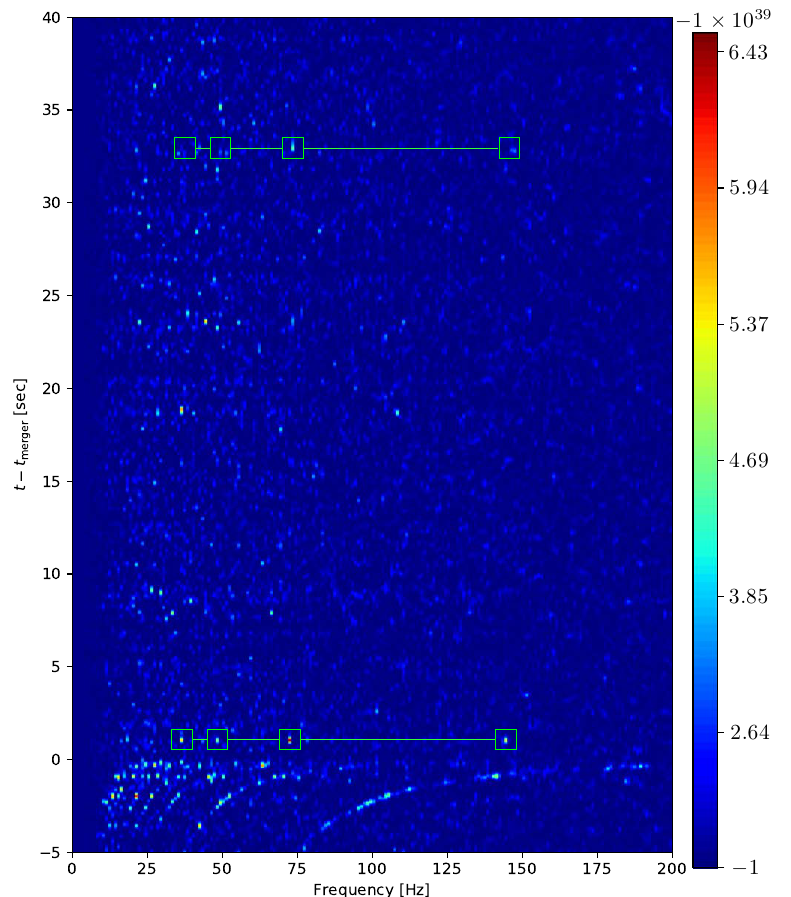
Figure 22. Time-frequency representations of X ( t , f ) (Equation (154); combining all harmonics with N ) around the merger for the BNS gravitational-wave event GW170817, frequencies n f , with n × ∈ observed through cross-correlating the two LIGO detectors [20]. The possible resonance peaks of echoes found in this plot are marked with a green squares. The color scale shows the peak at f peak = 72 ( Hz and t 1.0 s, is the highest peak in this diagram, from before and after the BNS merger t merger − (cid:39) (see Figures 23–25). A secondary peak at the same frequency but t in this plot.